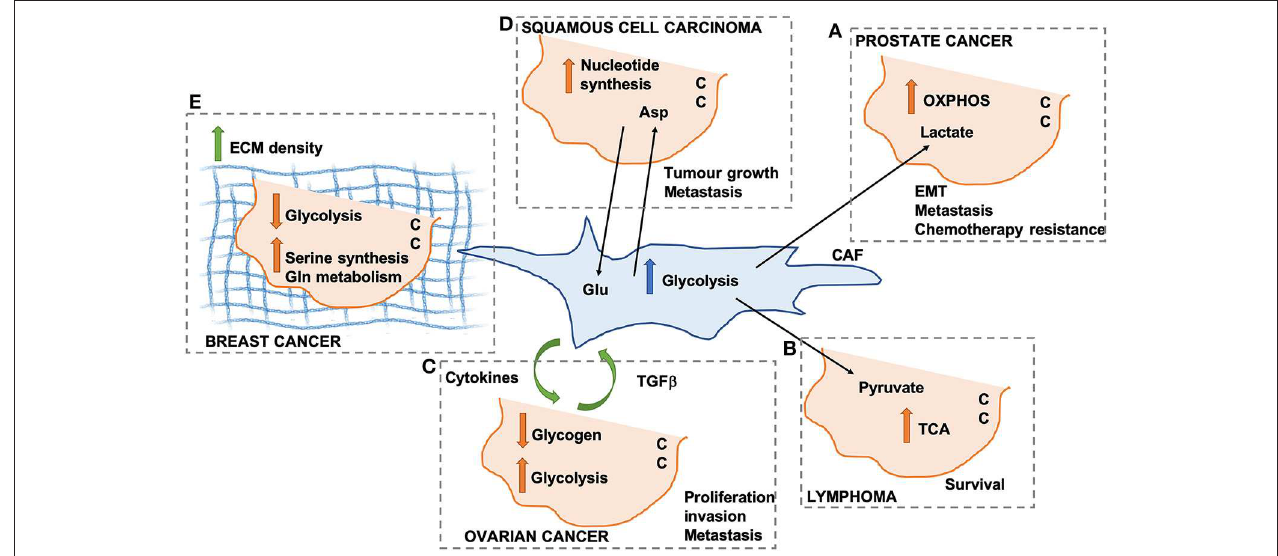
FIGURE 1 | Schematic representation of different mechanisms through which cancer-associated fibroblasts (CAFs) can modify cancer cell (CC) metabolism. OXPHOS, oxidative phosphorylation; TCA, tricarboxylic acid cycle; Glu, glutamate; Asp, aspartate; ECM, extracellular matrix. (A) Lactate secreted by CAFs promotes OXPHOS in pancreatic CCs. (B) CAF-derived pyruvate promotes TCA activation in lymphoma CCs. (C) Cytokines and TGF beta promote CAF-ovarian CC cross-talk. (D) Asp secreted by CAFs drives nucleotide synthesis in squamous cell carcinoma. (E) ECM density promotes Serine synthesis and Gln metabolism in breast